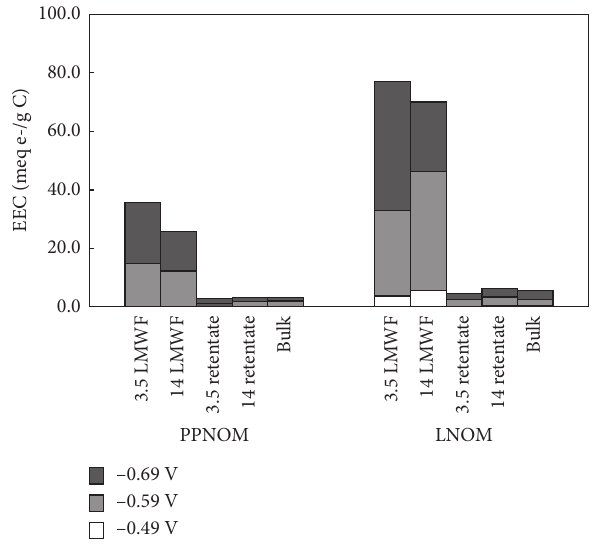
Figure 2: The EEC of PPNOM and LNOM.